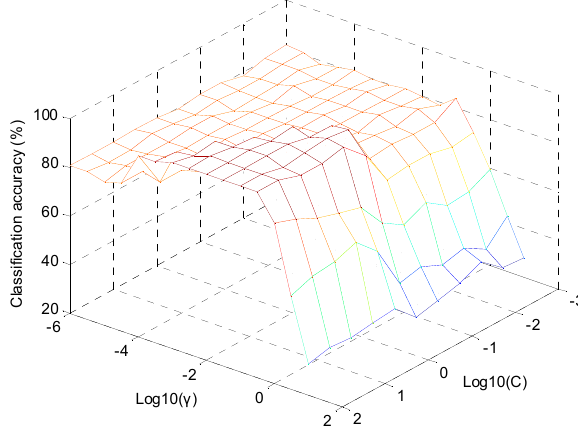
Figure 6. Classification accuracy of the support vector machine-discriminant analysis (SVM-DA) model according to different Log 10 (γ) and Log 10 (C) values.